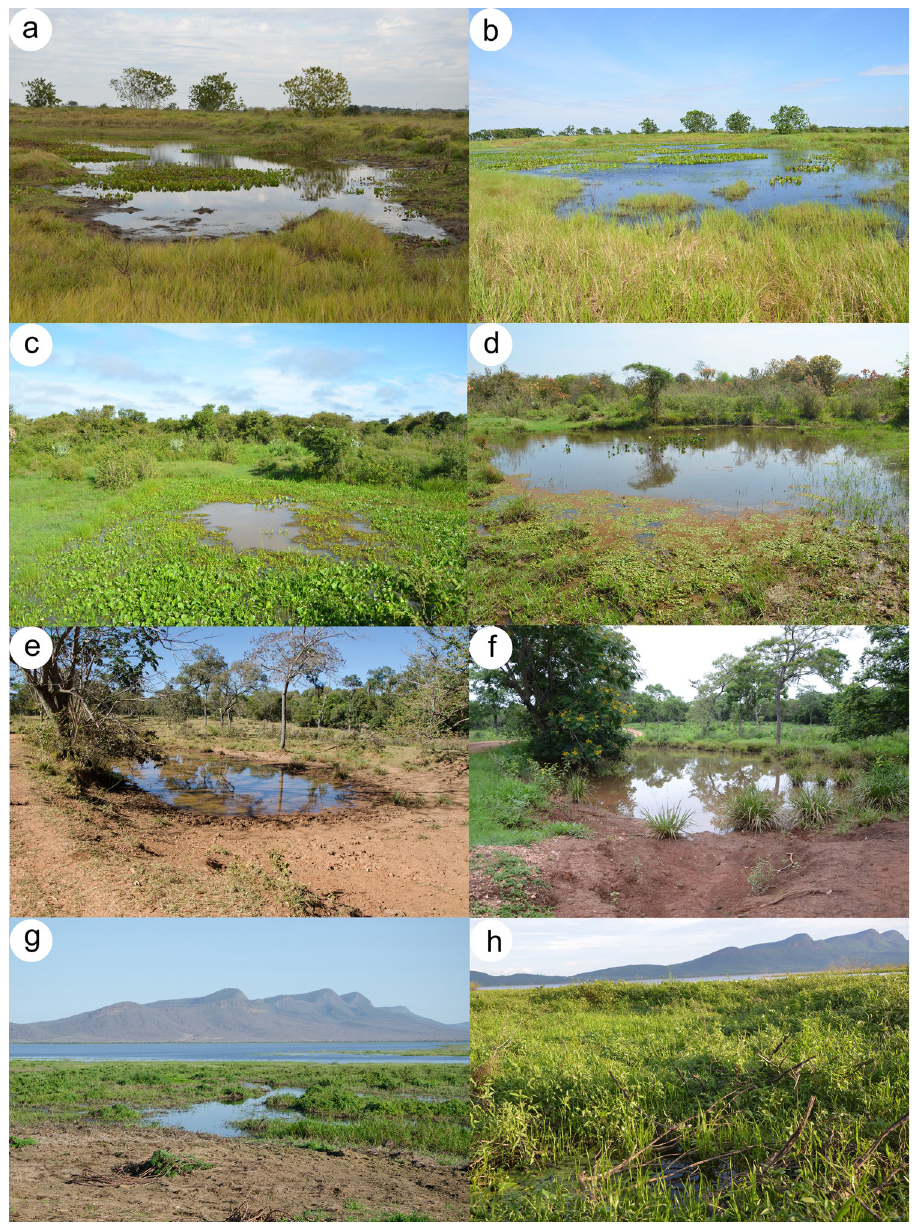
Fig 2. Some sampled sites during the dry and rainy season respectively in a–b) Atlantic Forest, c–d) Chaco, e–f) Cerrado, and g–h)